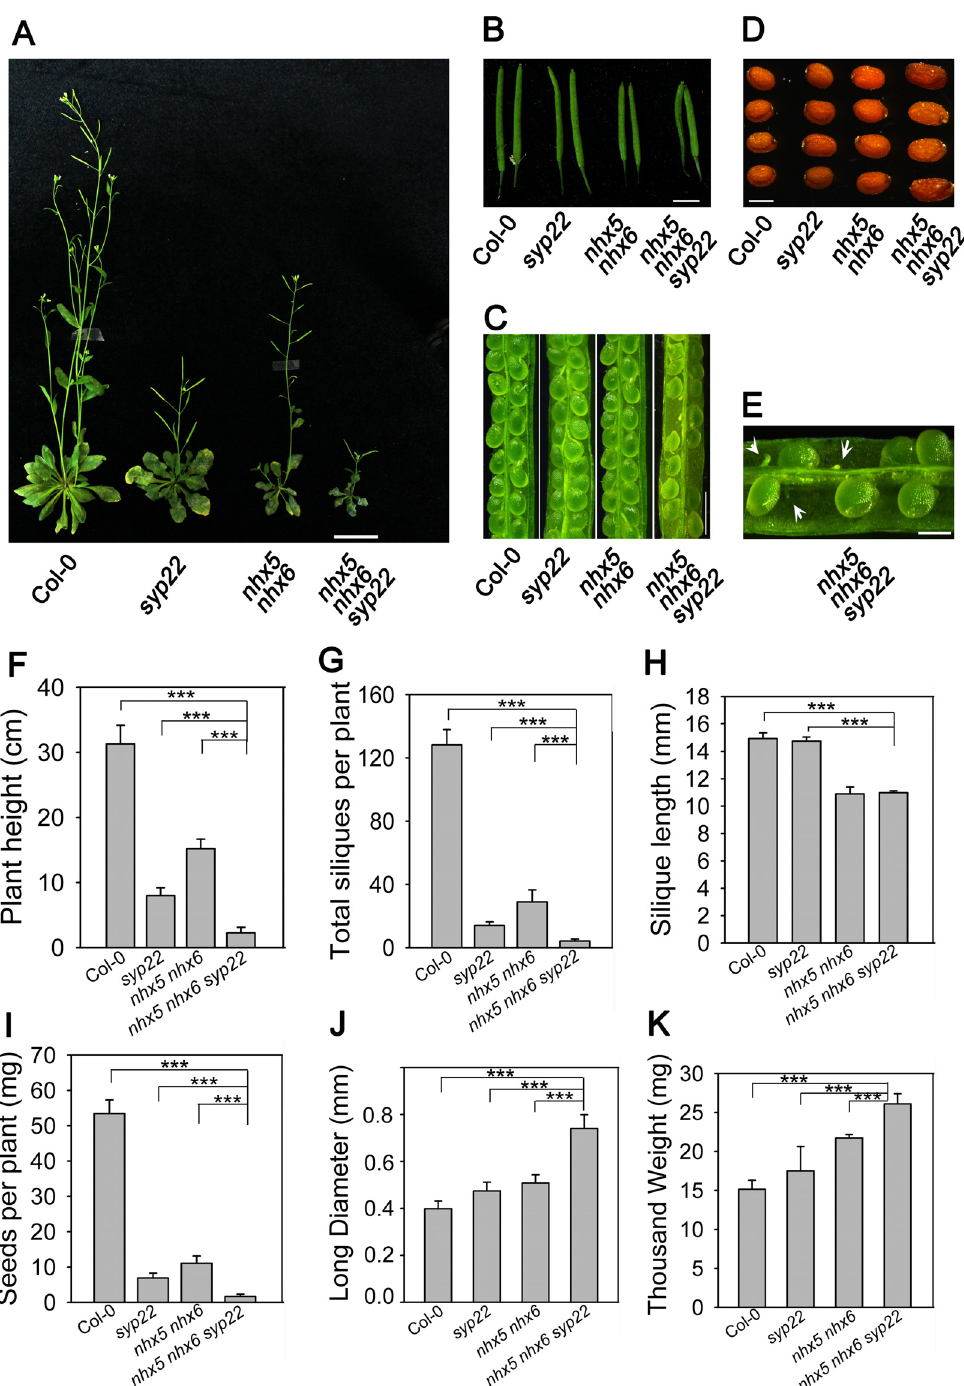
Fig 4. Seedling growth and seed development are altered in nhx5 nhx6 syp22 . (A) Phenotype of the triple mutant grown on soil for 60 days. (B) Silique phenotype. Photos were taken at 22 DAF. Bar = 0.5 cm. (C) The embryo morphology at 14 DAF. Bars = 1mm. (D) The mature seeds. Photos were taken when the seeds were dehydrated for 30 days after harvest. Bars = 0.5mm. (E) Embryo morphology of the triple mutant. Bars = 0.5mm. (F) Plant height. Error bars represent SD; n = 30. (G) Silique yield per plant. Error bars represent SD; n = 30. (H) Silique length. Silique length was measured on the main stem at 22 DAF. Error bars represent SD; n = 15. (I) Seed yield per silique. The total seeds per silique were counted on the main stem. Error bars represent SD, n = 15. (J) Long diameter of the dry seeds. Error bars represent SD. n = 300. (K) Thousand weight of the seeds. Error bars represent SD, n = 8. *** P (cid:1) 0.001, by t